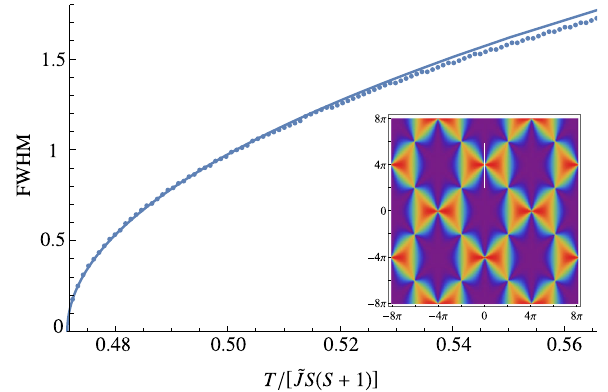
FIG. 4. The PFFRG data (dotted curve) showing the full width at half maximum (FWHM) (along the ½ 00 l (cid:2) cut, white line in the inset) of the pinch point as a function of the temperature in the classical isotropic nearest-neighbor Heisenberg antiferromagnet. The calculation is done in the bare RPA limit [see Appendix A], wherein the exact pinch-point pattern shown in the inset [plotted using the numerator in Eq. (A5)] naturally occurs due to the flat modes in the interaction matrix [see Eq. (19)]. However, this approximation (which accounts for only leading 1 =S dia- grams) contains a methodological artifact which manifests in the form of a divergence of the susceptibility at a finite temperature ffiffiffi p T= ½ ˜ JS ð S þ 1 Þ(cid:2) ¼ 2 = 3 [produced by the denominator of Eq. (A5)], at which the ½ hhl (cid:2) plane susceptibility shown in the inset is evaluated. Above this temperature, the width of the pinch points is seen to reproduce the T 1 = 2 behavior [4]. In Appendix A, we show how the inclusion of higher-order diagrammatic con- tributions in 1 =S cure this spurious divergence.